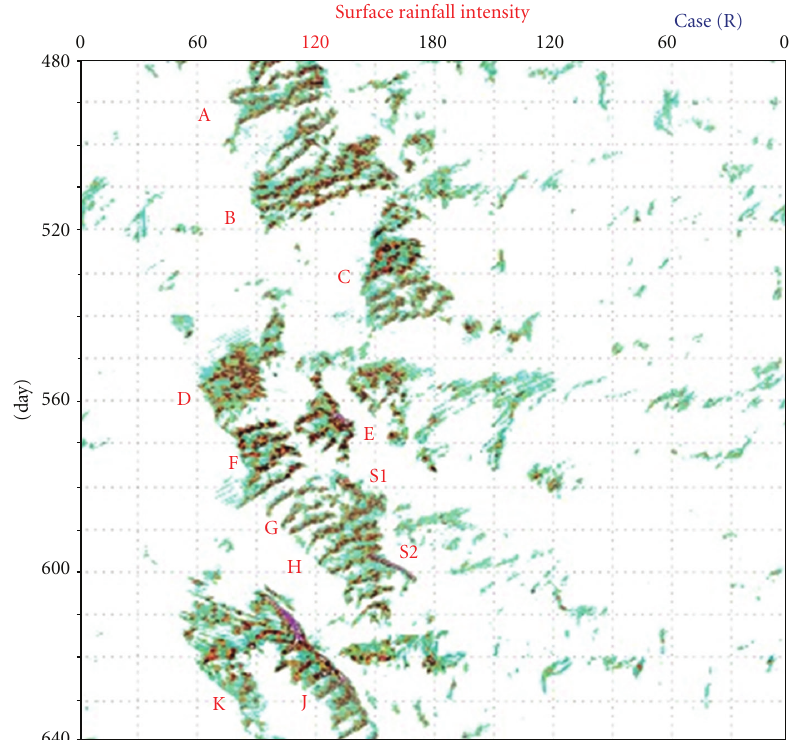
Figure 7: Longitude-time section (Hovm¨ollor diagrams) of the low-level rainwater mixing ratio in case (R). It is reproduced from Figure 6, but only a period from 480 to 640 days is shown. Each of synoptic-scale convective systems is labeled by A–K (except I). Squall-line systems are labeled by S1 and